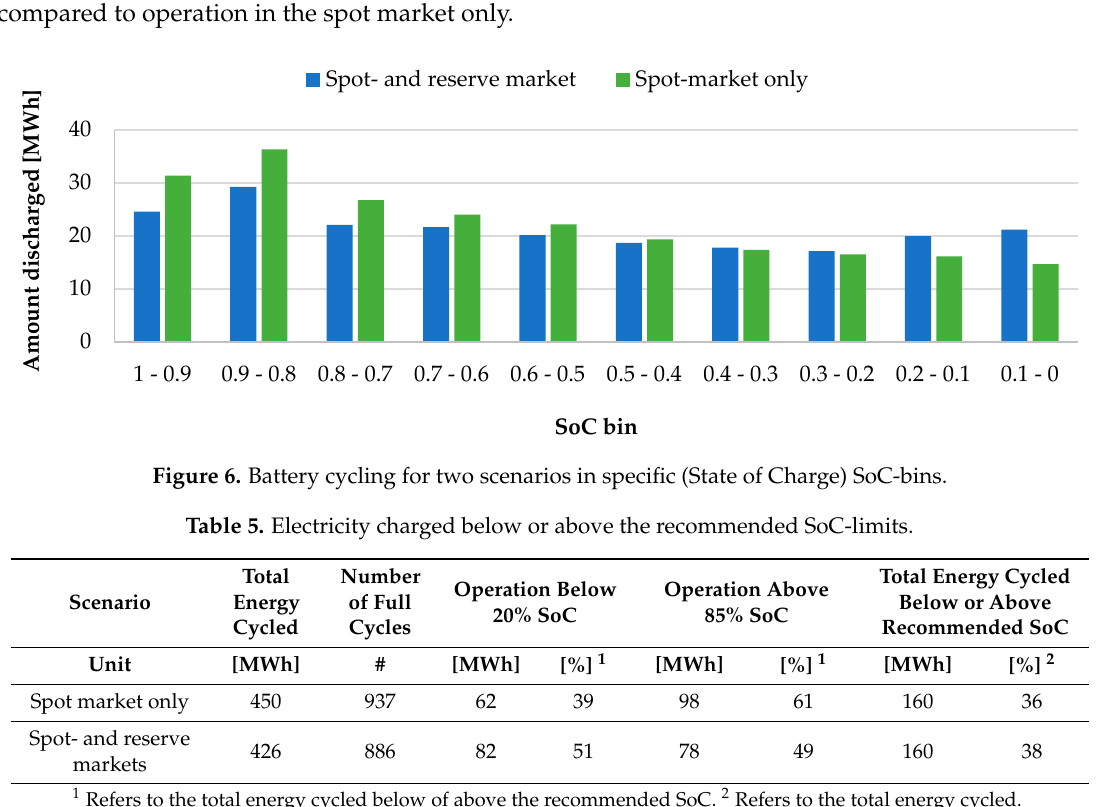
( b ) Figure 5. Monthly revenue/cost results: ( a ) Baseline including reserve market; ( b ) battery scenario including reserve market. 3.5. Battery Operation